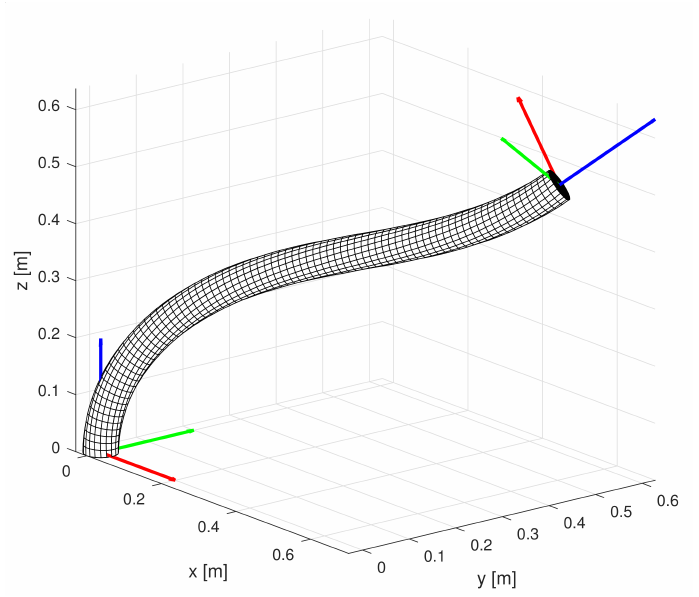
Figure 8. Flexible rod deformed in